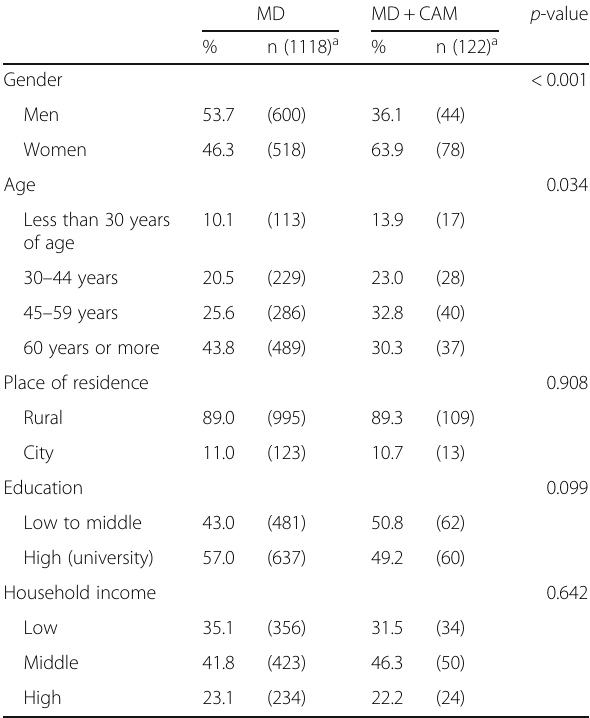
Table 1 Basic characteristics of